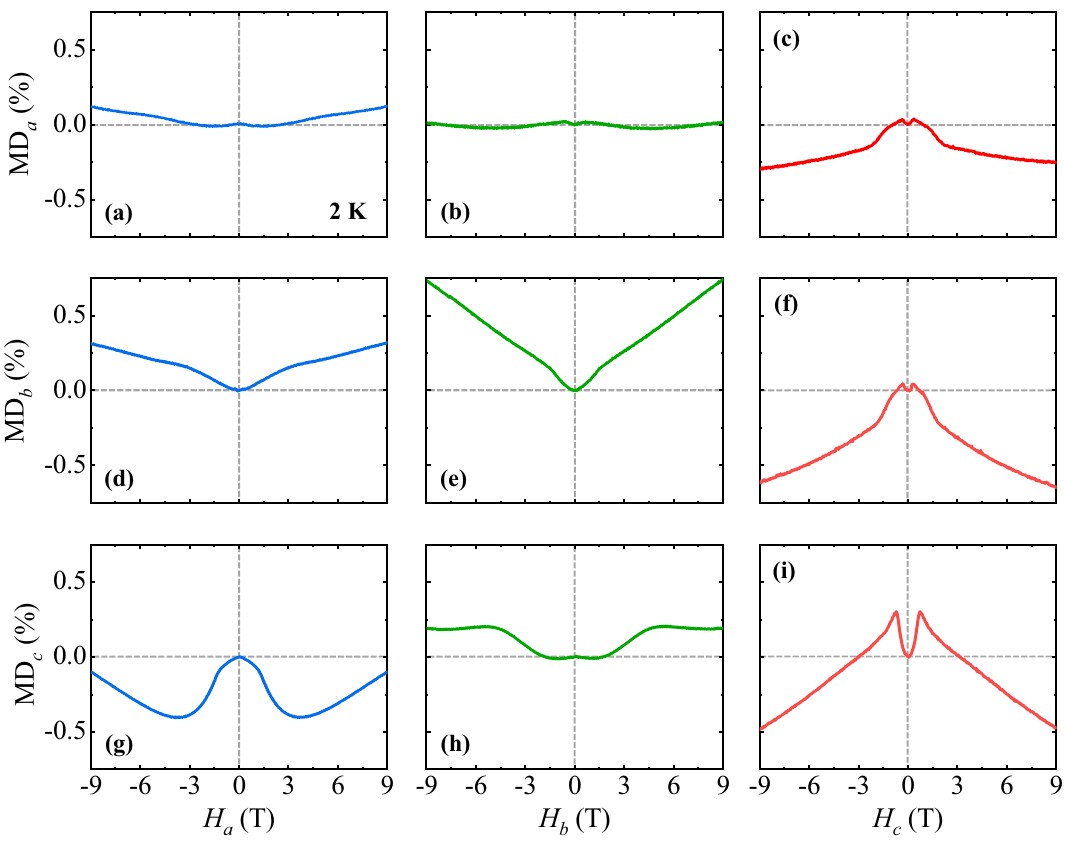
Figure 4. Magnetodielectric effect of ErFeO 3 . Magnetodielectric (MD) effect defined as MD ′ ( H ) − ε ′ ( 0T ) × 100 for ( a )–( c ) a (MD (%) = ε ε ′ ( 0T ) a ), ( d )–( f ) b (MD b ), and ( g )–( i ) c (MD c ) axes, respectively, at H a , H b , and H c up to ± 9 T and T = 2